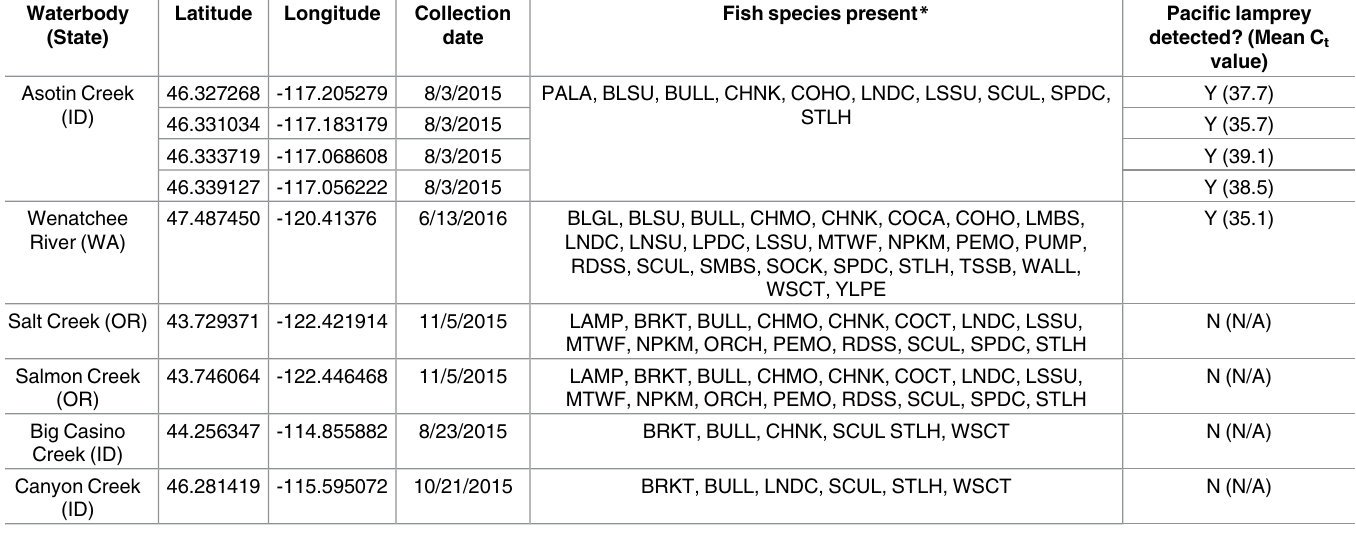
Table 4. Collection and species assemblage information for eDNA samples used to test the Pacific lamprey qPCR assay. Community assemblage information (fish species present) was obtained via a combination of eDNA analysisand personal communication with local tribal, state and federal biologists. Waterbody